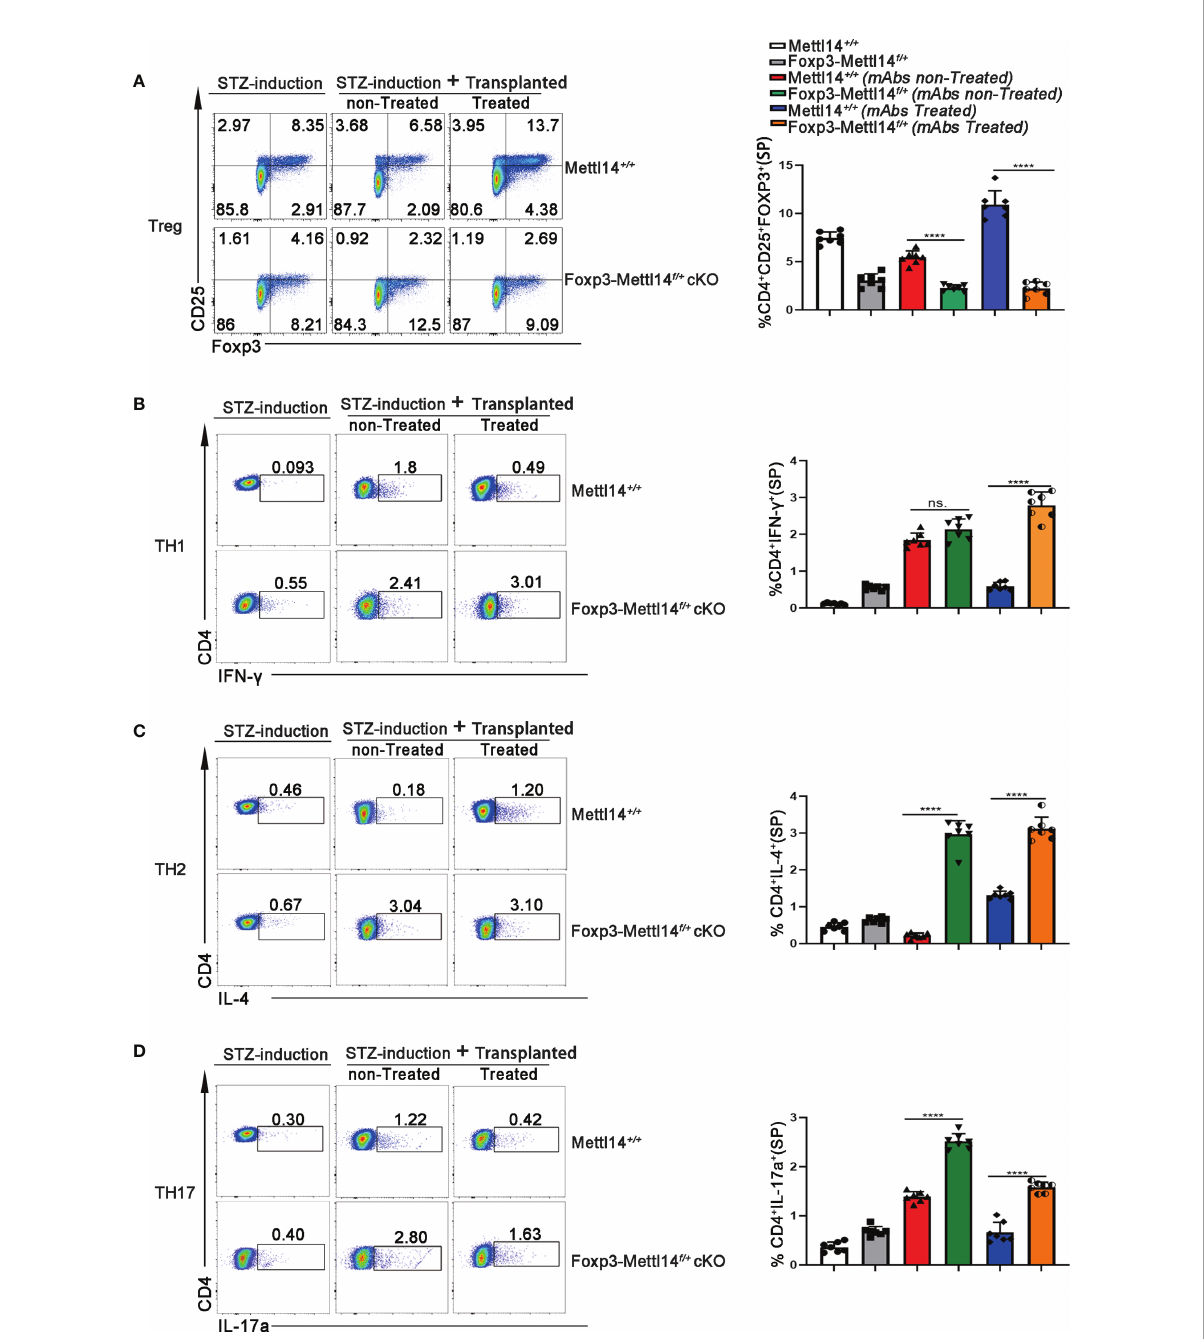
FIGURE 3 The METTL14 mediated m6A modi fi cation is needed to maintain the population of Treg cells post-transplantation. (A) Representative FACS analysis showing the proportion of Treg cells (CD4 + CD25 + Foxp3 + ) in among the CD4 + T-cell population in the spleens at day 7 after transplantation (n=7). In the presence or absence of mAbs, the proportion of CD4 + CD25 + Foxp3 + Treg cells was decreased in Foxp3-Mettl14 f/+ cKO mice compared to littermate controls after islets allograft transplantation. (B – D) Representative FACS analysis showing the proportion of TH1 (CD4 + IFN- g + TH1), TH2 (CD4 + IL-4 + TH2) and TH17 (CD4 + IL-17a + TH17) cells among the CD4 + T-cell population in the spleen at day 7 after transplantation (n=7). Compared to littermate controls, the proportions of other main subtypes of T-cell including CD4 + IFN- g + TH1 (B) , CD4 + IL-4 + TH2 (C) and CD4 + IL-17a + TH17 (D) were signi fi cantly increased in Foxp3-Mettl14 f/+ cKO mice after islets allograft transplantation. The data are shown as the means ± SD, the statistical analysis was performed with an unpaired Student ’ s t-test (two-tailed), ****P<0.0001. P>0.05 was considered nonsigni fi cant